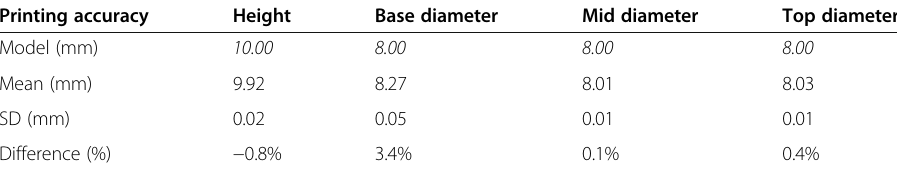
Table 2 Differences of measured dimensions from the printing model Printing accuracy